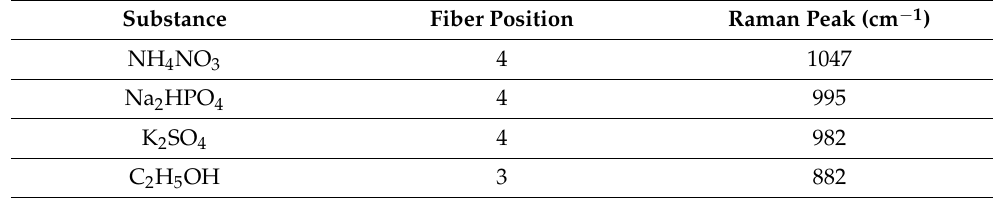
Table 4. Selection of glass fibers related to the selected peak in the substances to be investigated. Substance